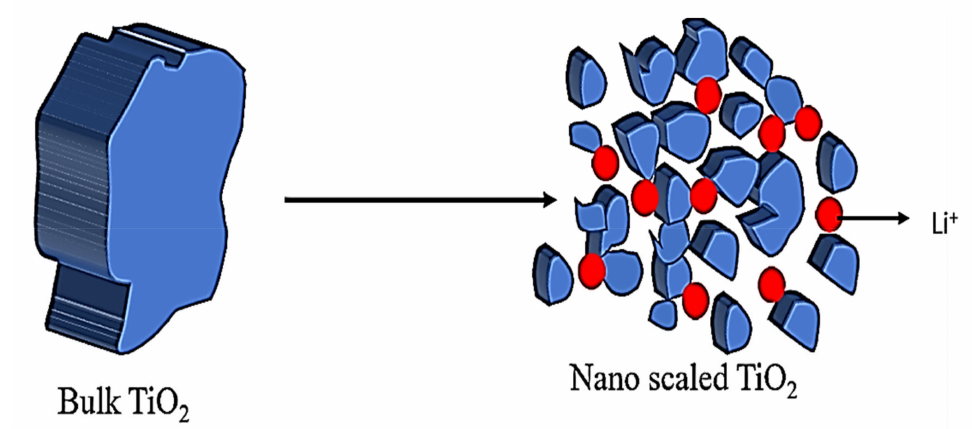
Figure 7. Nano scaling of TiO 2